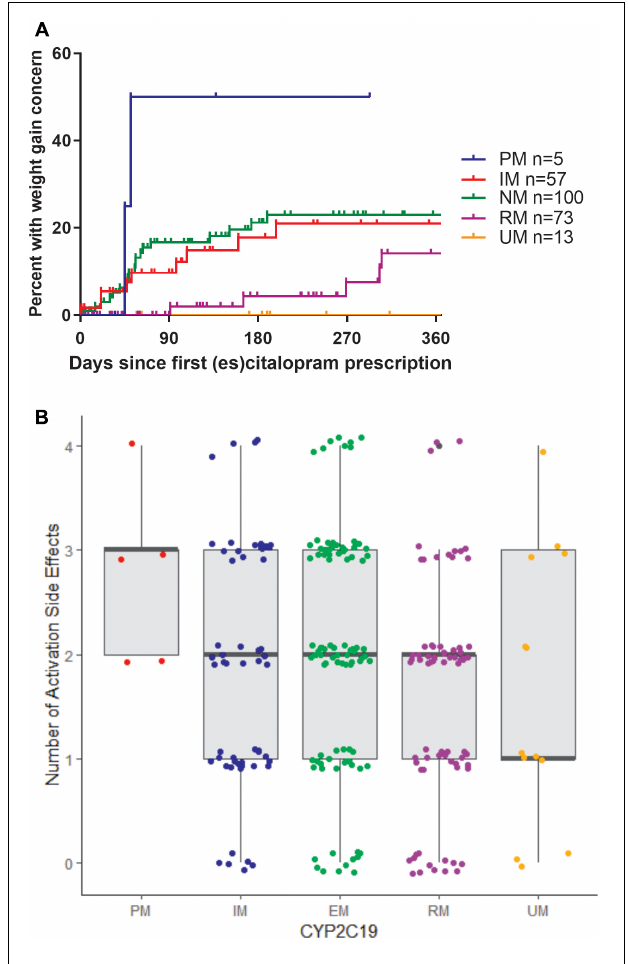
FIGURE 2 | (A) Cumulative days in the inpatient psychiatric unit (over the entire follow-up period after the initial hospitalization) correlated with the total number of side effects in a linear model (regression line in black p = 2 × 10 - 10 ). (B) Cumulative days patients were admitted to the inpatient psychiatric unit during treatment with es/citalopram after the initial hospitalization by CYP2C19 metabolizer status, p = 0.076. Mean and standard deviation are indicated by the bar and whiskers. PM, poor metabolizer; IM, intermediate metabolizer; NM, normal metabolizer; RM, rapid metabolizer; UM, ultrarapid metabolizer; n , number.